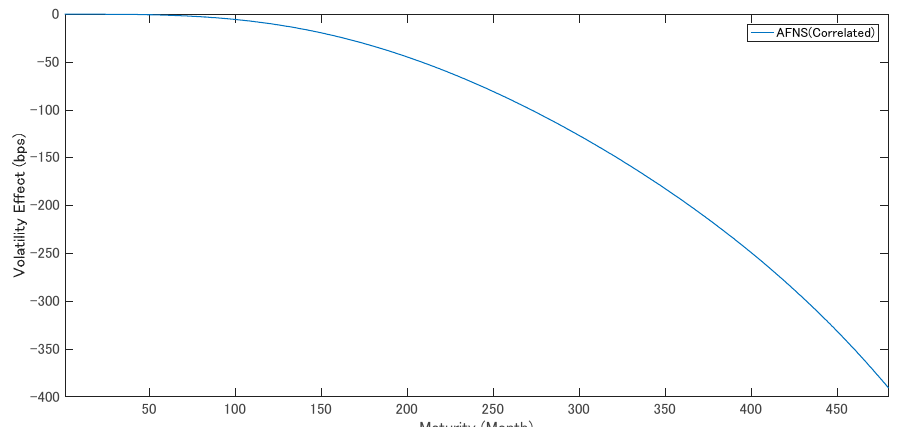
Figure 5. The volatility effect of the correlated AFNS. Note: The unit of the volatility effect is basis points (bps).